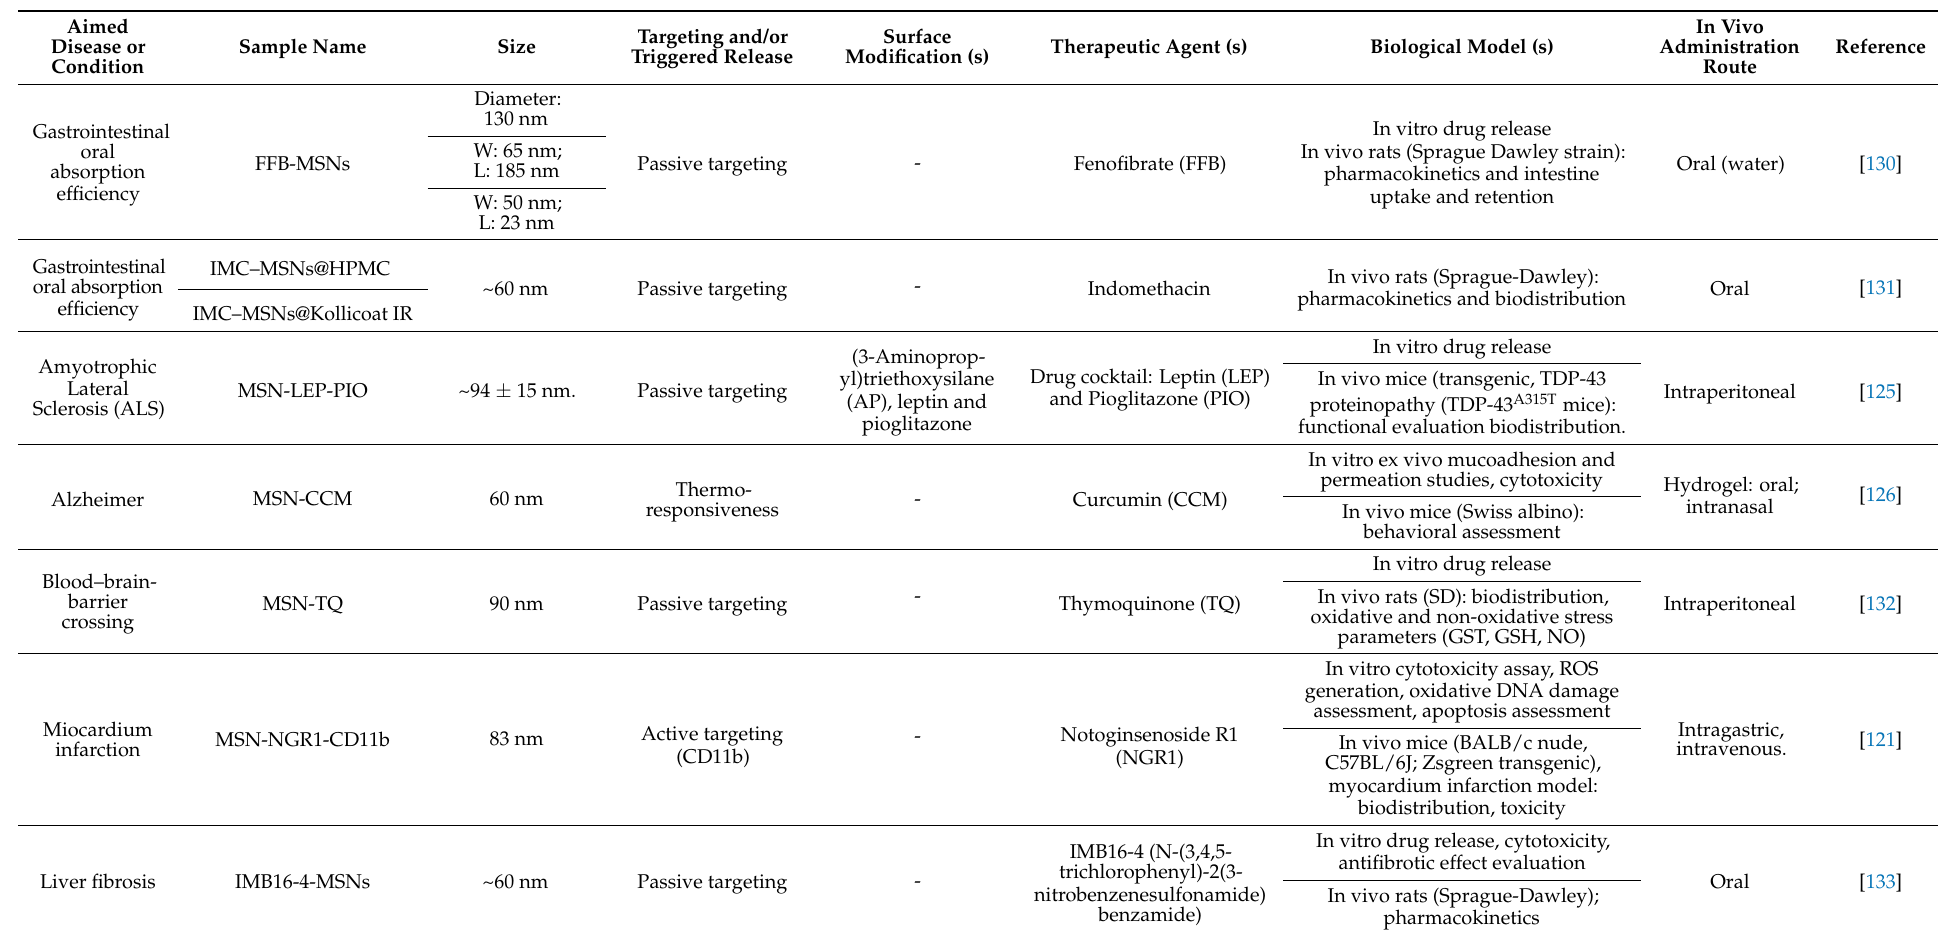
Table 1. Selected recent examples of MSNs developed as drug delivery systems and evaluated in biological models. Sample names used by the authors are included, since, in some cases, they provide information about the composition of the nanocarrier. EDTA: EthyleneDiamineTetraacetic Acid. MSN: Mesoporous Silica Nanoparticle. NA: Not Available. PEG: PolyEthylene